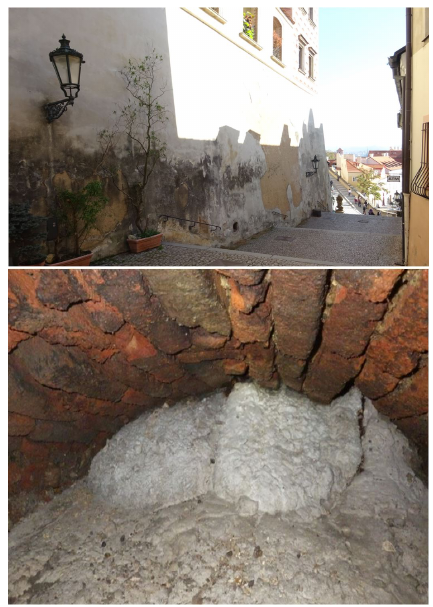
Figure 6. Carmel Monastery: Radniční Schody (Town Hall Stairs) - spalling of the plaster due to water-saturated backfill, the gallery clogged with con-